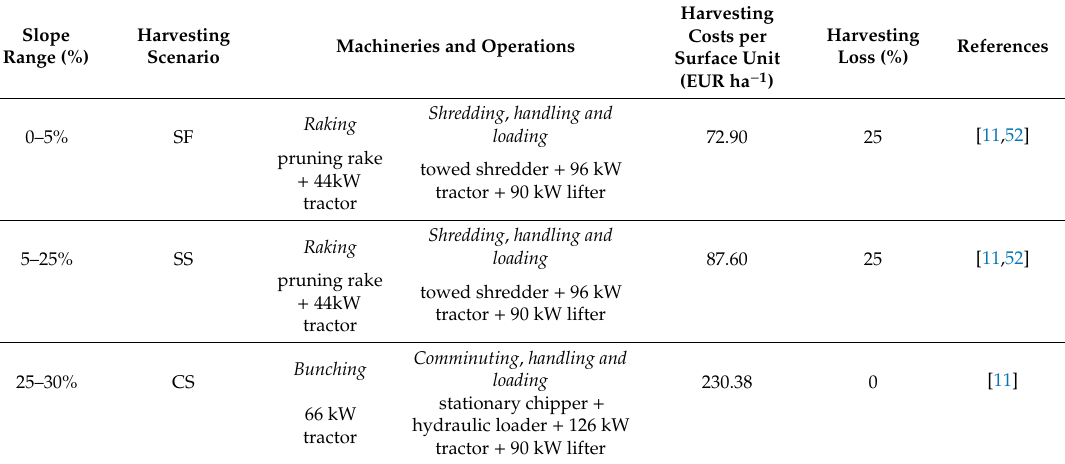
Table 1. Main characteristics of the harvesting